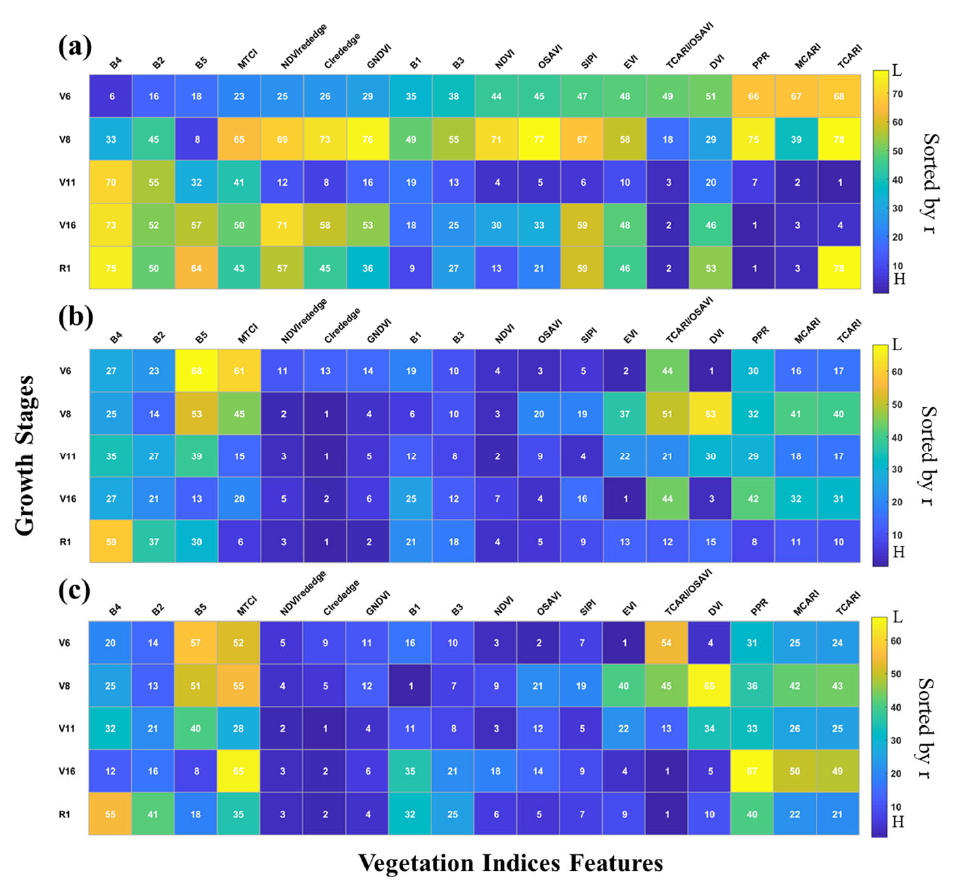
Figure 7. The ranking of the correlation between VI S features and the target variables. ( a ) The ranking of the correlation between VI S features and LCD. ( b ) The ranking of the correlation between VI S features and LAI. ( c ) The ranking of the correlation between VI S features and CCD. Note: The abscissa feature order of ( a – c ) is the descending order of the correlation between features and LCD at the V6 growth stage. The numerical value in the color bar represents the serial number of each feature. The smaller the serial number, the greater the r. For example, the number 1 represents the largest value of the r. H represents the high correlation; and L represents the low correlation. B1 represents the reflectivity of the first band of the multispectral image, and other similar.